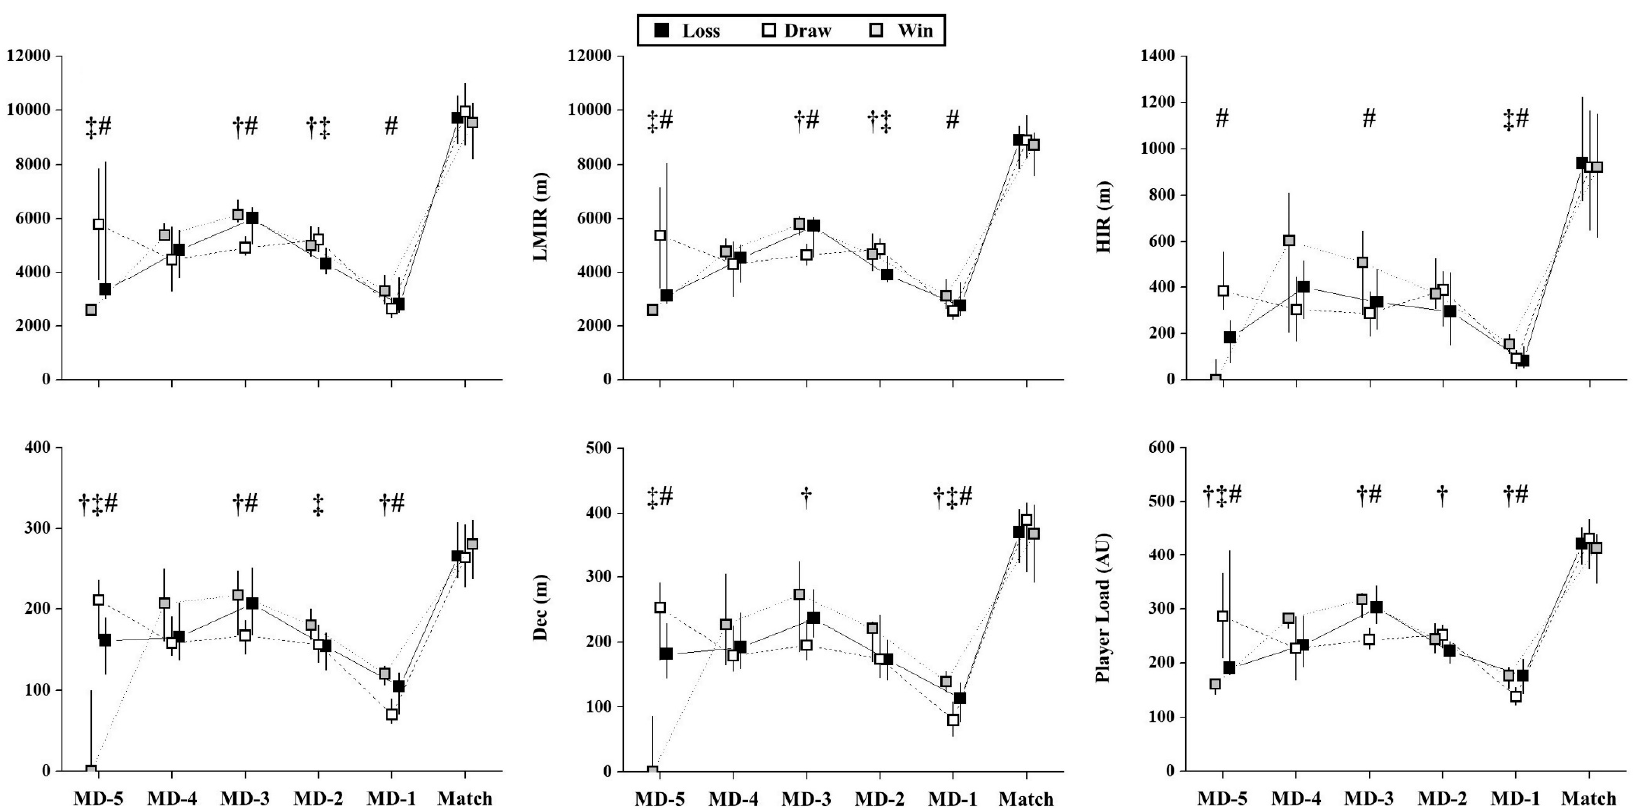
Figure 4. Weekly external load parameters according to match outcome (before a win, draw, and loss). TD: total distance covered; LMIR: total distance covered under low- to moderate-intensity running ( ≤ 18 m · h − 1 , m); HIR: total distance covered under high-intensity running ( > 18 km · h − 1 ); Acc: total distance covered under high-intensity acceleration ( ≥ 2 m · s − 2 ); Dec: total distance covered under high-intensity deceleration ( ≤− 2 m · s − 2 ) #: Significant di ff erences between days before win vs. draw ( p < 0.017); ‡ : Significant di ff erences between days before win vs. loss ( p < 0.017); MD-5 = five days before the match; MD-4 = four days before the match; MD-3 = three days before the match; MD-2 = two days before the match; MD-1 = one day before the match. † : Significant di ff erences between days before loss vs. draw ( p < 0.017).